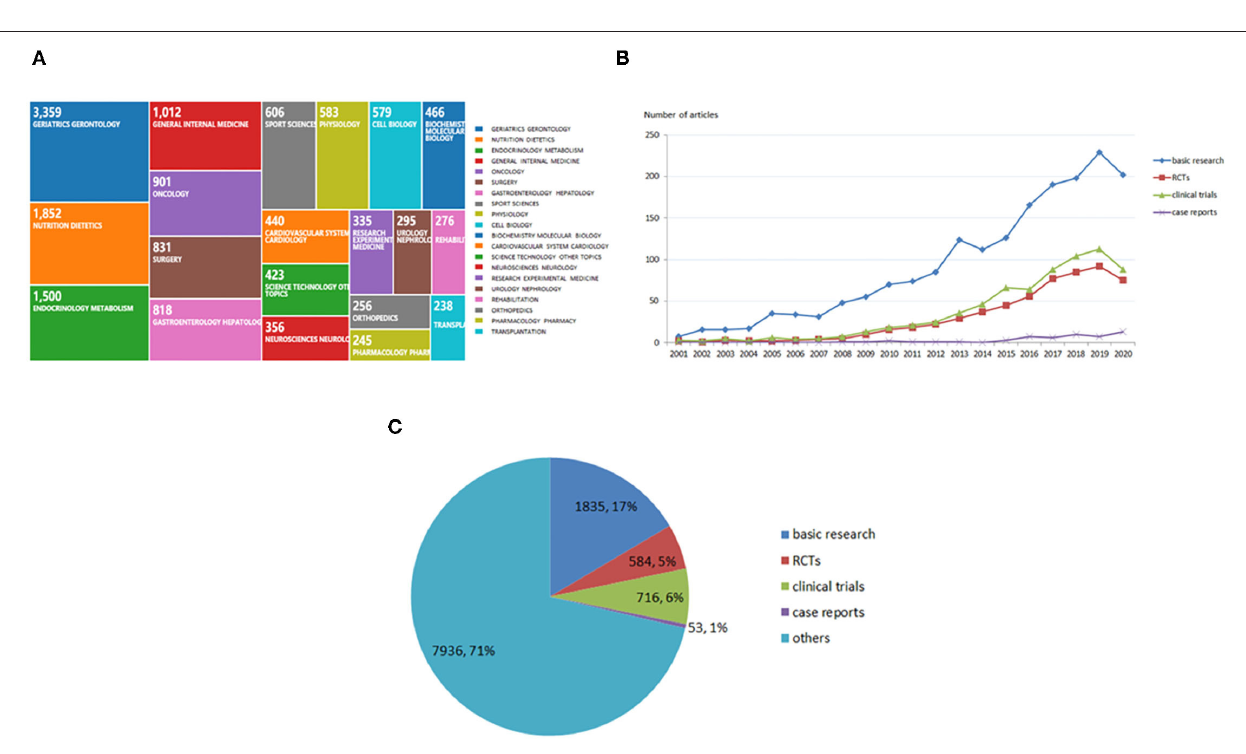
publications and had 19,544 total citations and 68 h-index ( Figure 2